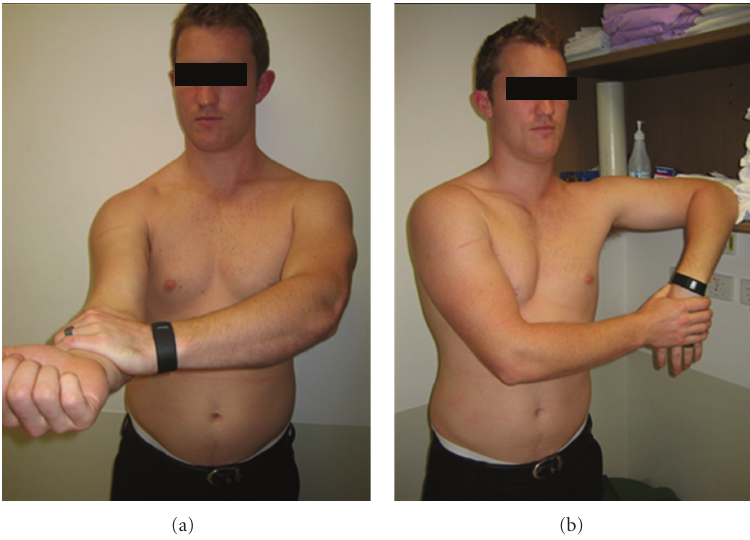
Figure 1: (a) Participant performing Speeds test. (b) Participant performing Hawkins-Kennedy.